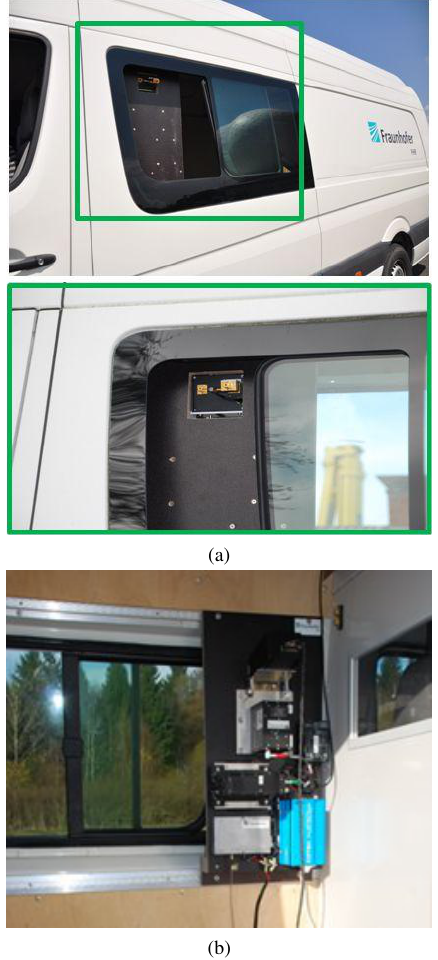
Figure 3: MIRANDA-300 SAR system: Operation and installa- tion of SAR sensor in van. The radar is mounted on a platform inside the van behind the window. While operating the system the window is opened. The radar is pointing to the left side with a variable depression angle of usually 30 degrees.(a) Exterior of van: Only antennas are visible behind open window. (b) Interior of van: Integration of sensor front- and back-end.